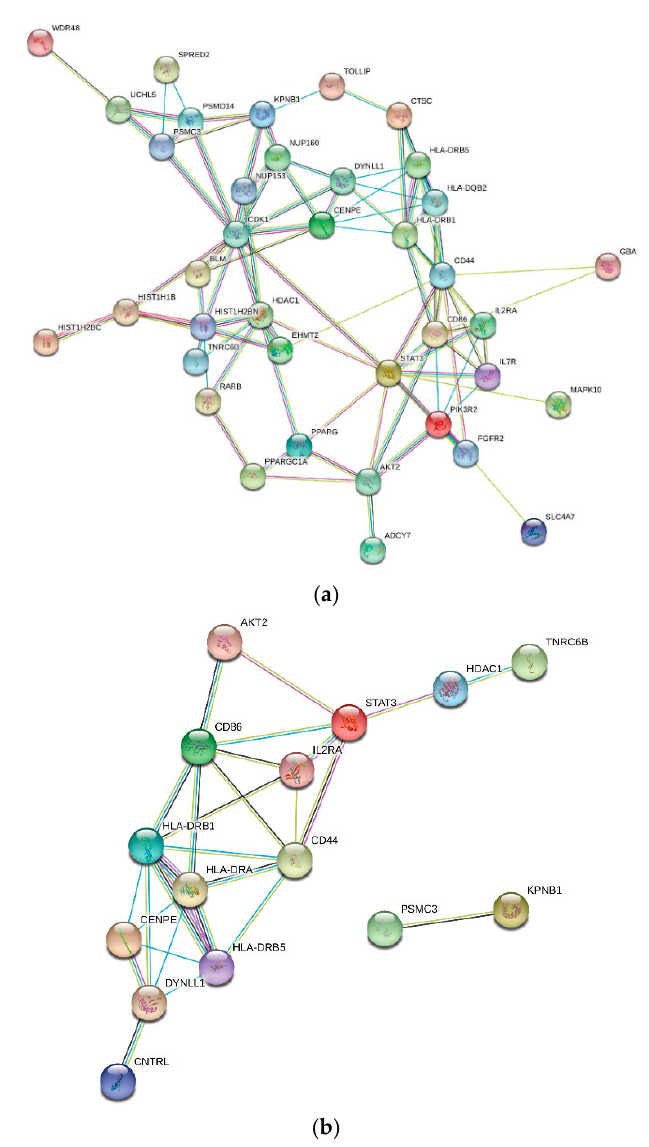
Figure 4. STRING protein–protein interaction of COVID-19 comorbidity-associated genes with involvement in influenza and/or SARS. STRING protein–protein interactions of MAGMAv1.07b identified genes with direct involvement with ( a ) influenza (CIS = 0.4). Influenza ( n = 46) and/ or ( b ) SARS (CIS = 0.4). SARS ( n = 17) are shown. Level of stringency in STRINGv11.0 program was